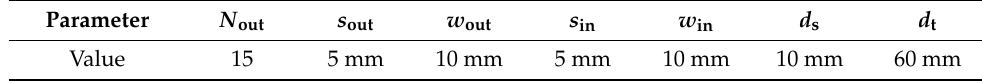
Table 1. Geometric parameters of electromagnetic